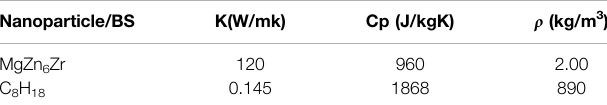
TABLE 1 | Thermophysical values for the base solvent and nanoparticles.